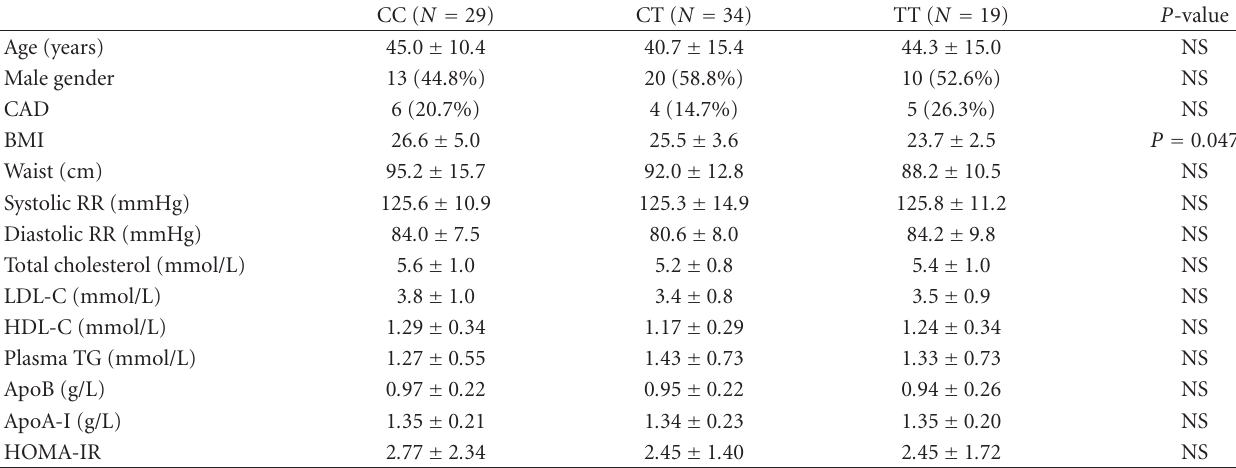
Table 2: Baseline characteristics for C573T polymorphisms. Data are given as mean ± standard deviation unless stated